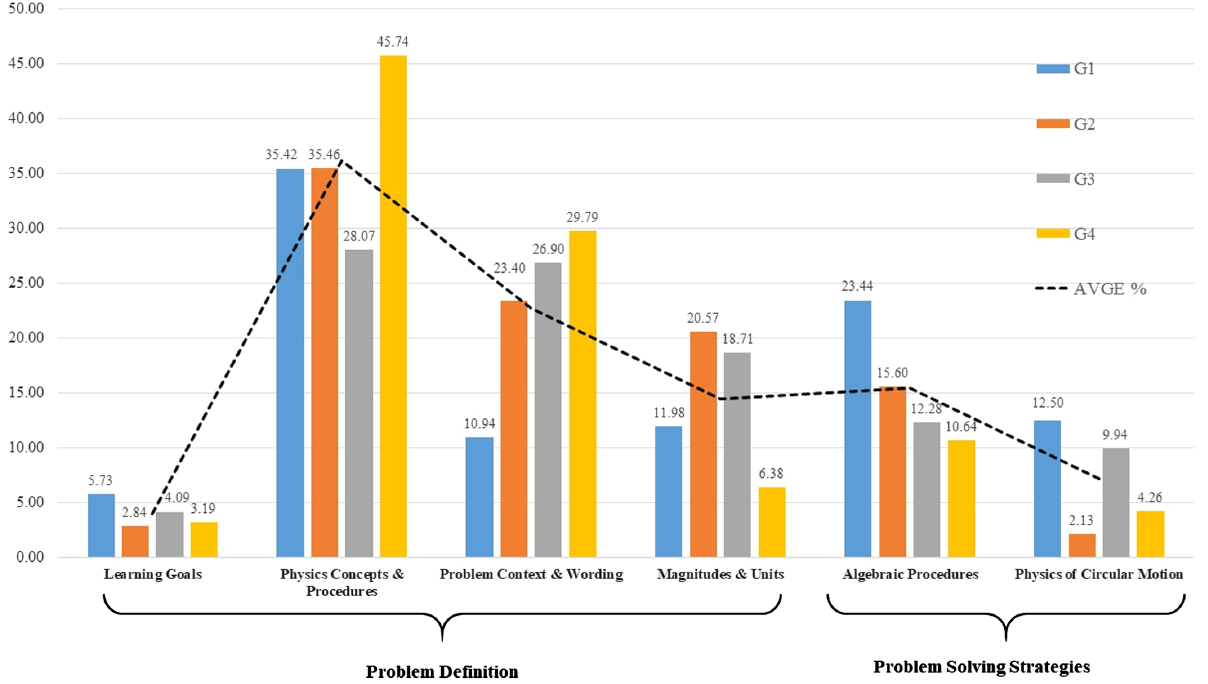
FIG. 3. Percentage of coded themes by group. Dotted line represents the average percentage across the four